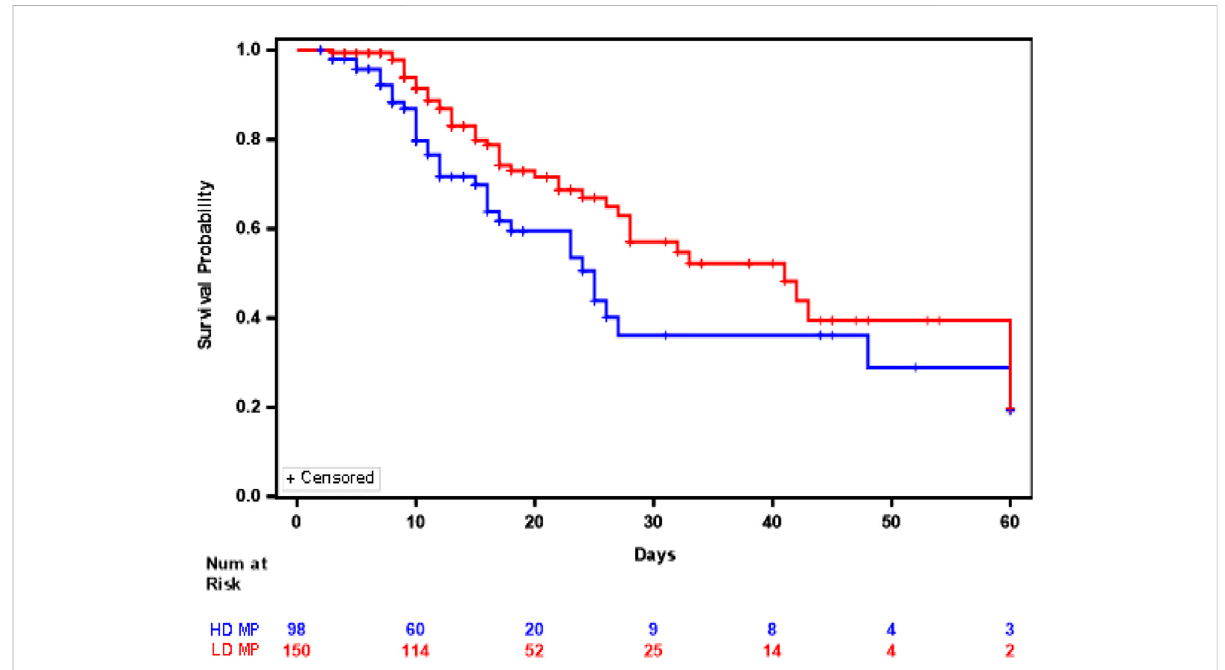
FIGURE 2 Kaplan Meier Plotof In Hospital Survival between patients whoreceived high dose methylprednisolone, hydroxychloroquine,and azithromycin (Blue) versus those who received low dose methylprednisolone, hydroxychloroquine and azithromycin